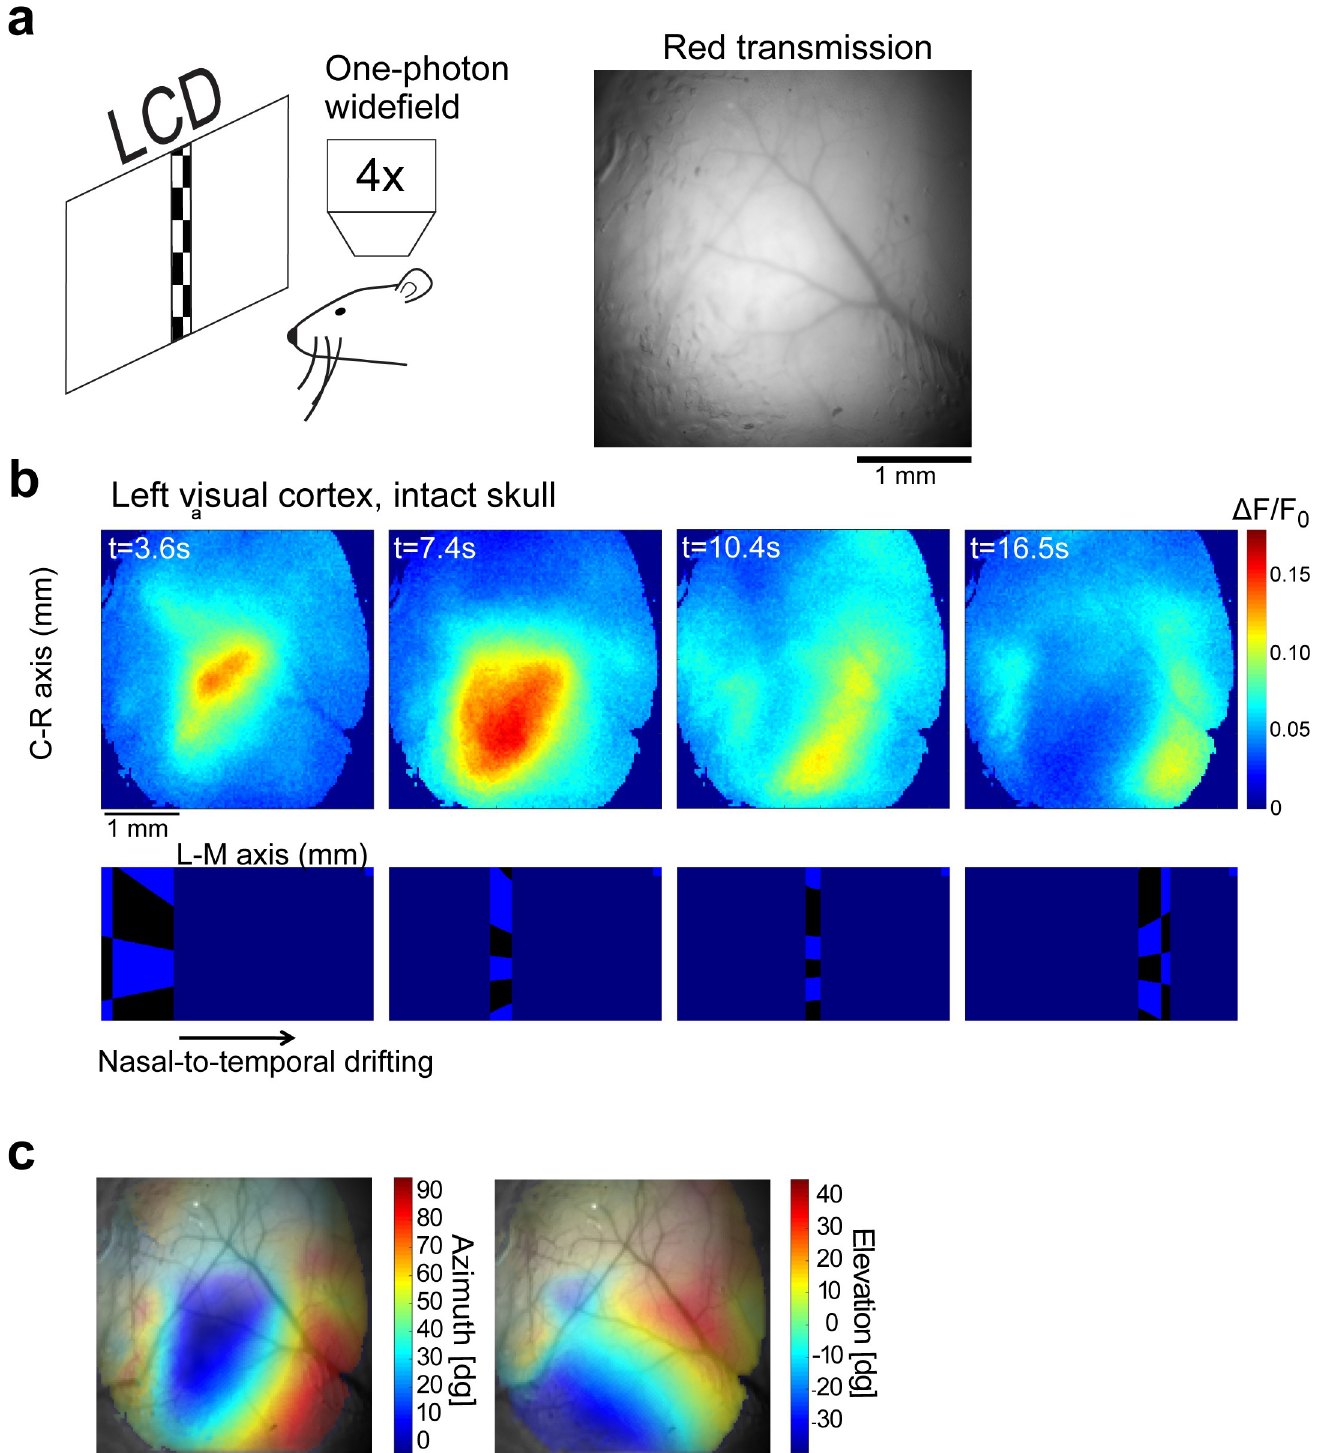
Fig 4. Widefield fluorescence imaging through the intact skull. a , Schematic of widefield imaging and an image of the brain through the intact skull of a 6-weeks old GP8.20 mouse, taken with a red filter set (585 nm dichroic; 630/75 nm emission bandpass filter). b . A typical time-lapse sequence capturing activity in the visual cortex (top) elicited by a drifting checkerboard stimulus (bottom) (averaged over 20 stimulus repetitions). Note that the cortical activity splits into two gradients, corresponding to the primary visual cortex and the lateral visual cortex (same mouse as in a) . c . Retinotopy maps superimposed on the cortical surface acquired by yellow emission filter (550nm dichroic; 575/40nm emission bandpass filter) to enhance the contrast of blood vessels. The degree of transparency was set according to the normalized amplitude of the visual response (stronger response ! lower transparency, same mouse as in a ). https://doi.org/10.1371/journal.pone.0205444.g004 PLOS ONE | https://doi.org/10.1371/journal.pone.0205444 October 11,